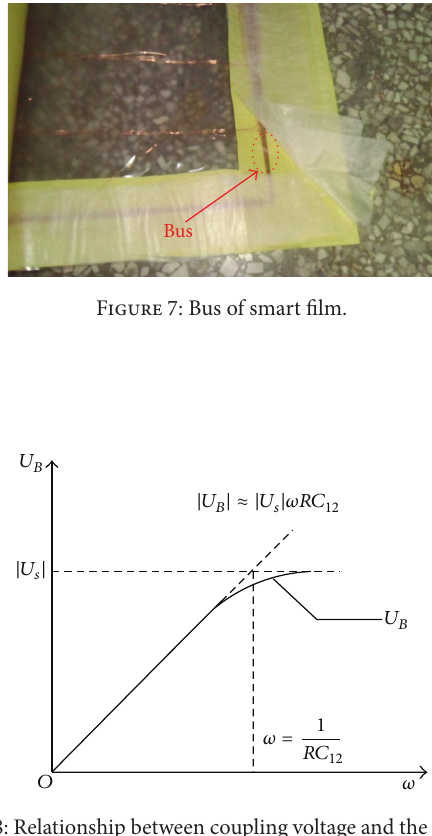
Figure 8: Relationship between coupling voltage and the frequency of detecting